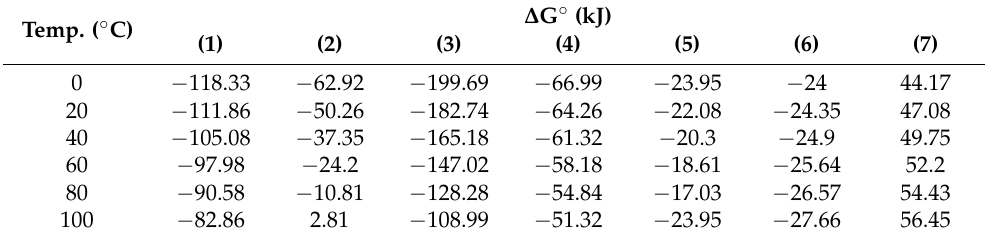
Table 2. ∆ G ◦ values of CAF dust leaching in the H 2 SO 4 system. Temp. ( ◦ C)